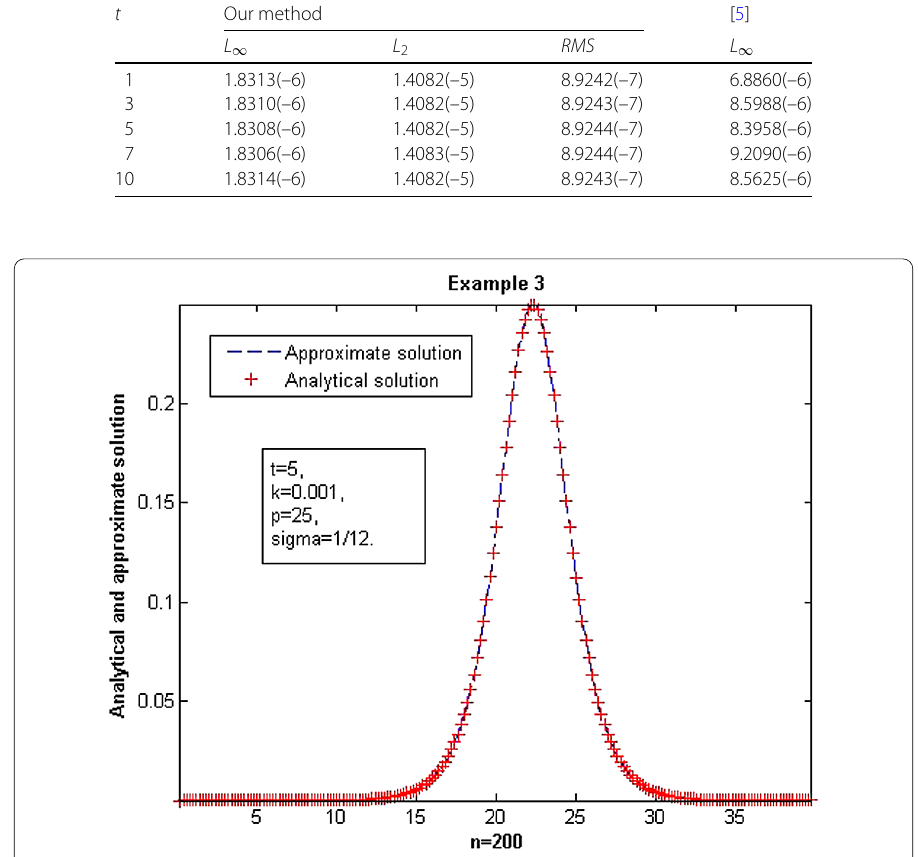
Figure 3 Comparison between analytical and approximate solution